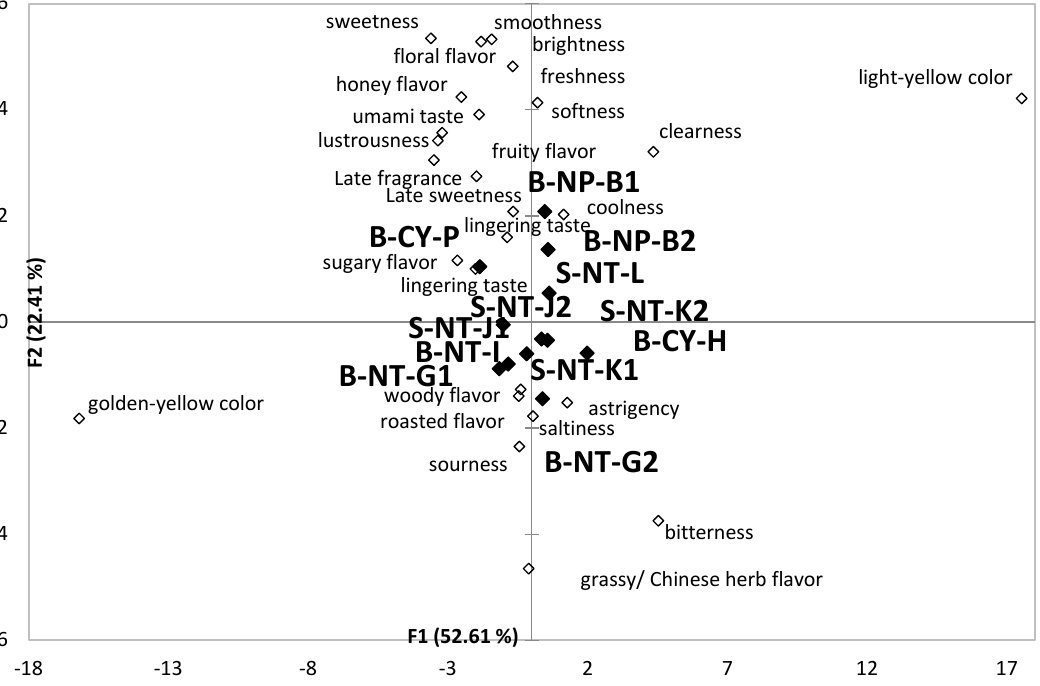
Figure 6. A bi-plot by PCA for the cold infusions of the 12 Taiwanese GABA Oolong tea made by the TTES #12 in association with the 21 sensory attributes selected by more than 20% of participants. Significant difference ( p < 0.05) of panelists’ selection proportions for each attribute among the seven tea samples were determined by Cochran’s Q test. The pairwise post-hoc McNemar test (Bonferroni) was also performed, and the tea samples signed with different alphabet letters were significantly different in the frequencies of panelists’ selection for the attribute listed in the same row.